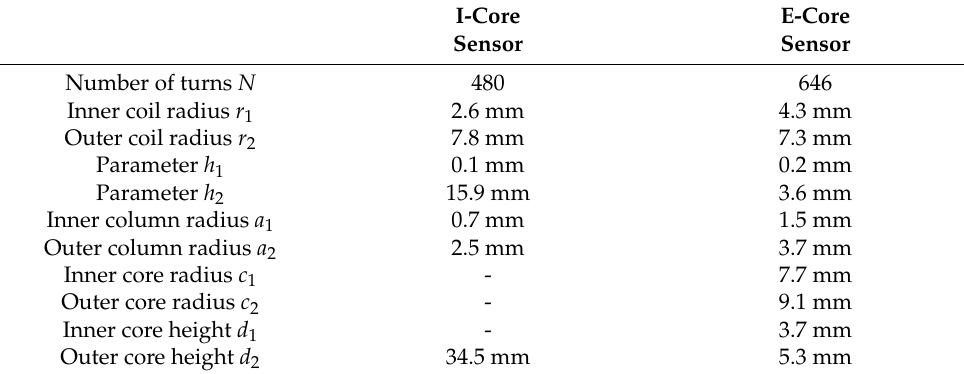
Figure 3. E-core sensor, I-core sensor and samples made of aluminium ( σ = 36.26 MS/m), copper ( σ = 58.38 MS/m), brass ( σ = 17.25 MS/m) and copper ( σ = 58.49 MS/m), used in the tests. Table 1. Geometric dimensions and parameters of the sensors.